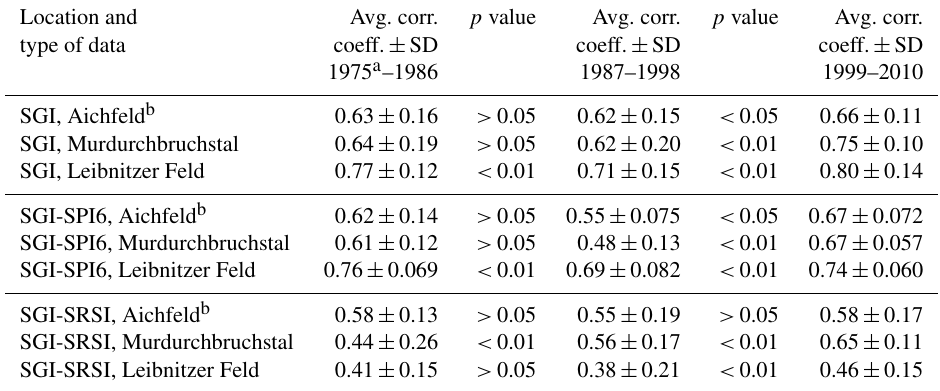
Table 5. Average Pearson correlation coefficients of a subregion for SGI time series with each other, SGI time series with the SPI6 and SGI time series with SRSI with their standard deviations for each subregion and each time period. Also shown is the p value indicating the statistical significance of the difference between the correlation coefficients of the two time